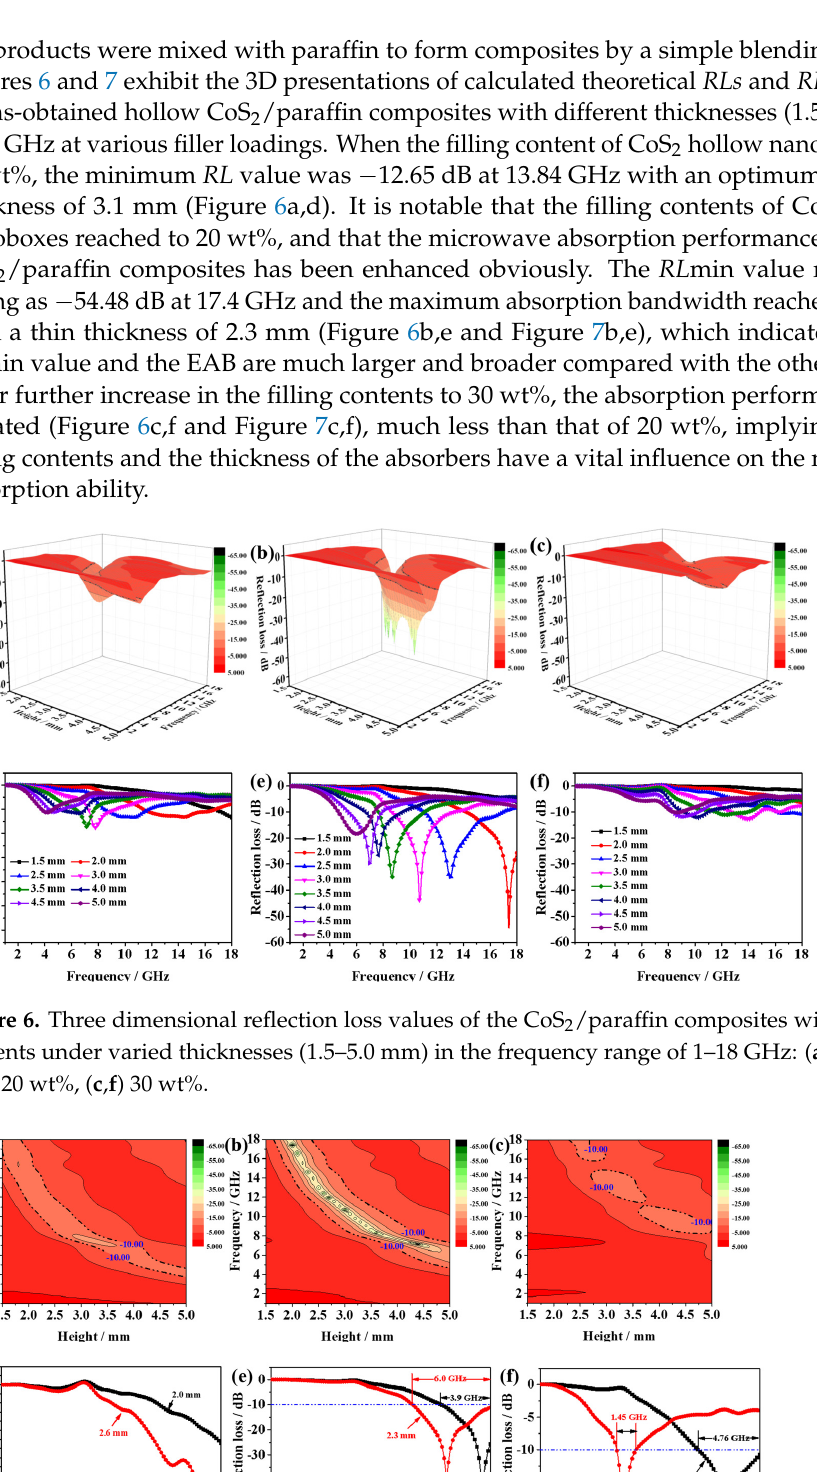
samples differ with the layer thickness (Figure 8a). We conducted a comparison of the RL